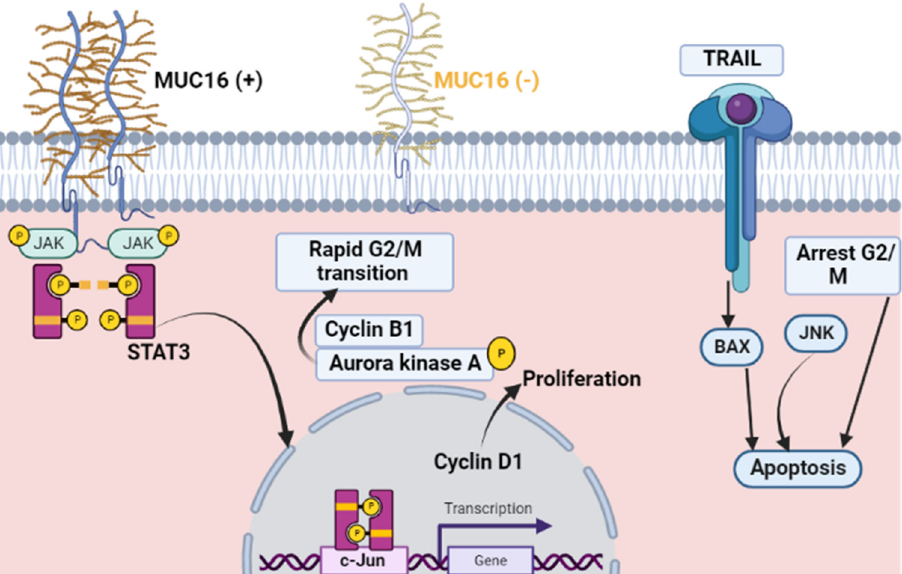
Figure 1. MUC16 expression in cancer: The MUC16 expression (+) stimulates tumor cell division via its binding to the non-receptor tyrosine kinase JAK2, which stimulates transcription factor STAT3 phosphorylation, which activates the expression of c-Jun for Cyclin D1. MUC16 influences the G2/M transition process via Cyclin B1 and phosphorylation of Aurora kinase A. Reduced expression of MUC16 ( − ) leads to malignant cells accumulation during the cell cycle’s G2/M phase with subsequent apoptosis of breast cancer cells via JNK signaling.